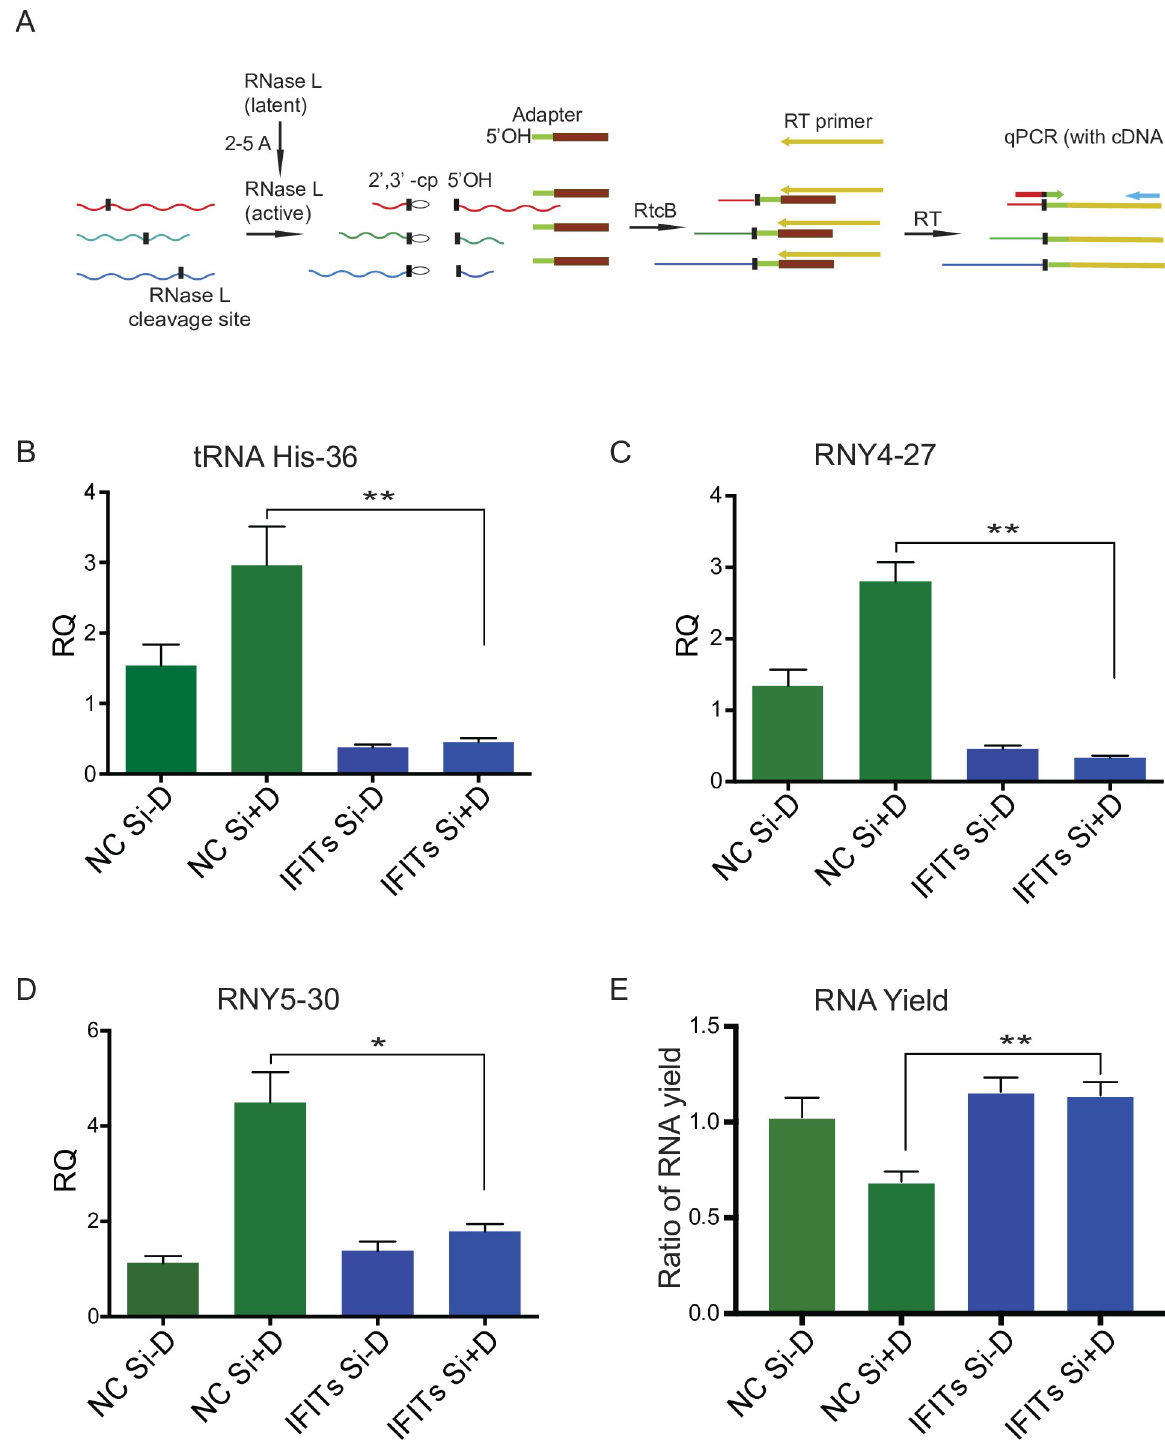
Fig 6. Activation of RNase L in cells depleted of IFIT2, IFIT1 and IFIT3. iSLK cells were depleted of IFIT1, IFIT2 and IFIT3 (IFITs) with siRNAs or mock depleted with negative control siRNA (NC Si). Cells were induced to permit lytic KSHV replication by treatment with doxycycline or mock-induced. RNA was harvested at 48 hr from each sample. U6 was used for normalization. (A) Diagram of site-specific qPCR for detection of RNase L site-specific cleavage. RNAs cleaved by RNase L and containing a 2 0 ,3 0 -cyclic phosphate (waved lines, black vertical bar) were ligated using RtcB to an RNA-DNA adaptor (green-brown) containing a 5’OH RNA (green). The EDTA-quenched ligation reaction was used as a template for reverse transcription with Multiscribe RT. Reverse transcription was carried out using a primer with a 3 0 -end